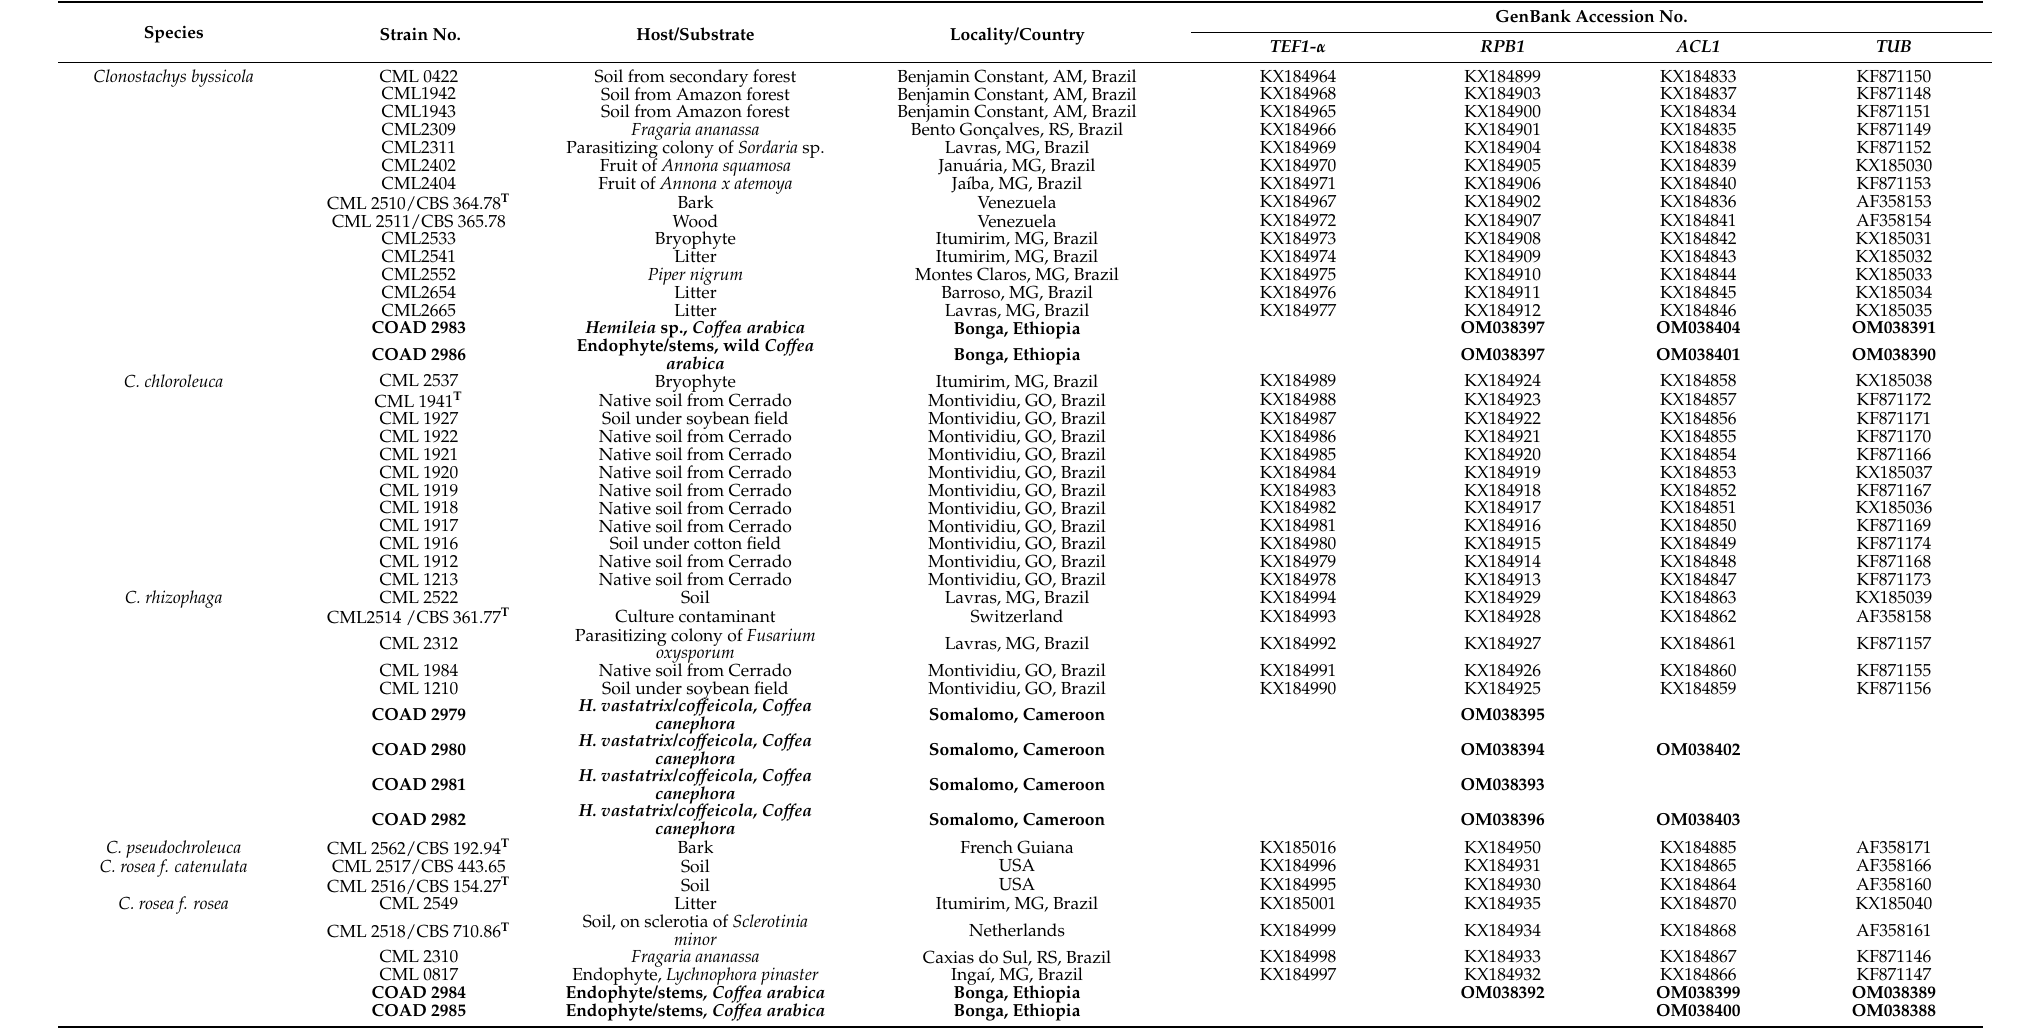
Table 1. Details of the Conostatchys isolates from coffee and other substrates included in the phylogenetic analysis. Species Strain